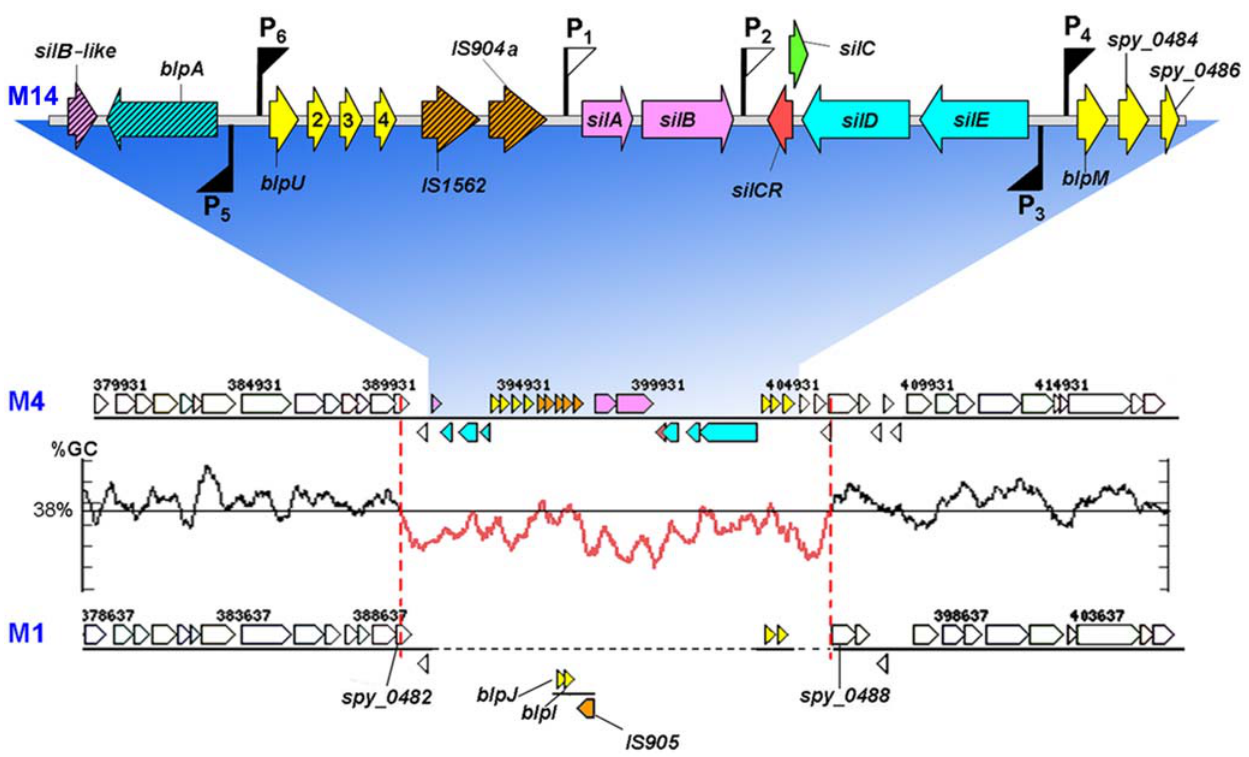
Figure 4. The transcriptional organization of the extended sil locus. The transcriptional organization and the gene content of sil as deduced from this study in the M14-type JS95 strain is enlarged (not to scale) (GenBank accession no GQ184568). Bold arrows indicate genes and flags represent promoters induced (filled) or non-induced (empty) by SilCR. Striped bold arrows symbolize pseudogenes. Key to colors: yellow, bacteriocin- like peptides; blue, ABC transporter systems; ochre, IS elements; pink, TCSs; red, signaling peptide. For gene alignment, , 10 kb DNA segments located upstream and downstream of sil in the M4-type strain MGAS10750 containing sil (GenBank accession no NC_008024) were aligned with those of the sil -deficient M1-type strain SF370 (GenBank accession no NC_002737) using the Integrated Microbial Genomes (IMG) version 2.8 program [55]. The GC plot across sil in strain MGAS10750 was produced by the freak software (EMBOSS package [39]), using a stepping value of 100 and an averaging window of 500. The blpI , blpJ and IS905 genes, present in the M1-type strain SF370, display no homology with sil from either MGAS10750 or JS95 strains, therefore these genes are positioned separately.